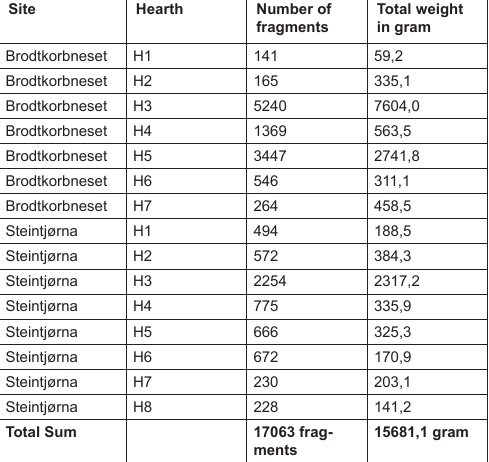
Table 3. Amount of animal bone fragments in the dif- ferent hearths from Brodtkorbneset and